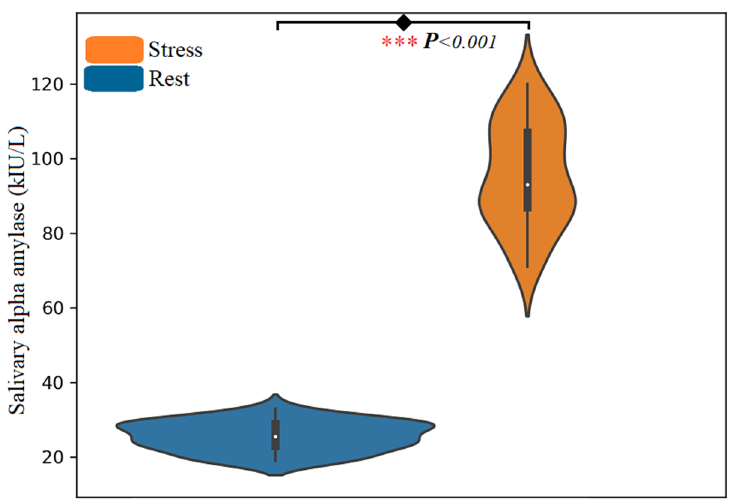
Figure 4. The average score of salivary alpha-amylase level responses for stress and rest tasks. Two measurement samples (5 min before (baseline) and 5 min after the last stress task). The “***” marks indicate the task is significant with p < 0.001.